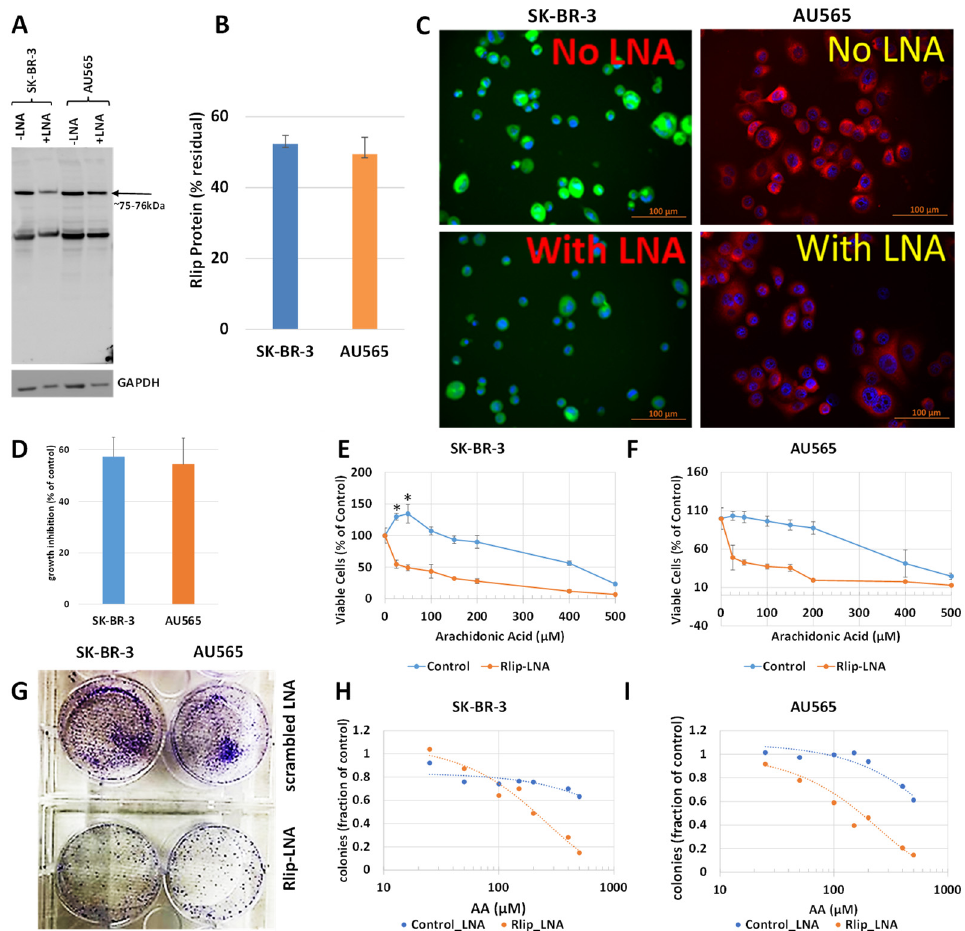
Figure 1. Effect of AA on p53 mutant breast cancer cell survival with and without Rlip depletion by Rlip-LNA: SK-BR-3 and AU565 cells were Rlip depleted by Rlip-LNA transfection at 24 h prior to AA treatment. ( A ) Efficiency of Rlip depletion was checked by Western blot, where GAPDH was used as a loading control for total cellular proteins. ( B ) Scanning densitometry results of Western blots showing similar levels of depletion of Rlip in SK-BR-3. ( C ) Depletion of the Rlip protein was also demonstrated by fluorescence immunocytochemistry against anti-Rlip antibodies and DAPI nuclear stain according to Materials and Methods (scale bar 100 µ m). The secondary antibody used was FITC for SK-BR-3 and Texas Red for AU565 cells. ( D ) The effect of Rlip depletion by transfection of Rlip-LNA on cell proliferation was determined by MTT assay. The bar diagram shows mean ± SD of percent growth inhibition (n = 3 separate determinations) compared with control scrambled LNA. ( E , F ) Effect of varying concentrations of AA on cell proliferation was determined for both cell lines by MTT assay. Cells were treated with AA 24 h after transfection of either Rlip-LNA or scrambled control-LNA, and MTT assay was performed 48 h later. ( G ) Effect of Rlip-LNA on clonogenic growth, and ( H , I ) the effect of AA on clonogenic growth with or without Rlip-LNA. The data were analyzed by a two-tailed Student t -test. One-way analysis of variance (ANOVA) with Tukey’s post hoc test was applied to compare all groups. Treatment with 25 or 50 µ M AA significantly increased proliferation above control in the SK-BR-3 (* p < 0.05) but not the AU565 cell line. ( G ) Representative images of colony formation assay as observed after crystal violet staining after Rlip-depleted and non-depleted cells were grown in culture for 14